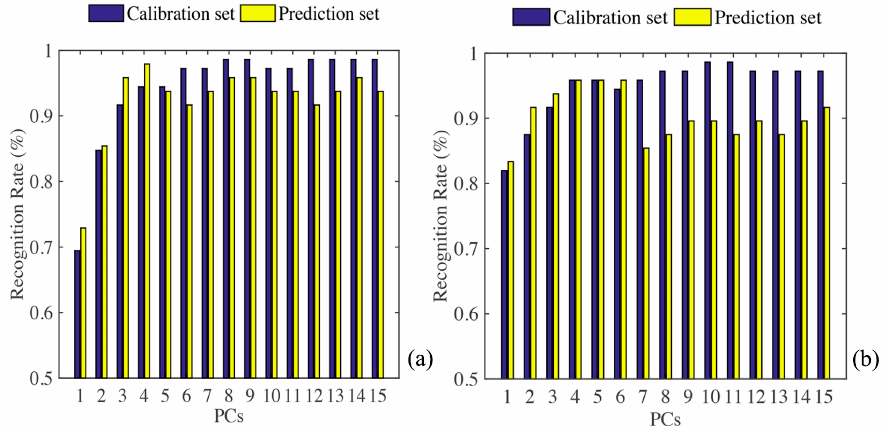
Figure 4. ( a ) Linear discriminant analysis (LDA) results using data from all sensors; ( b ) feature sensors.